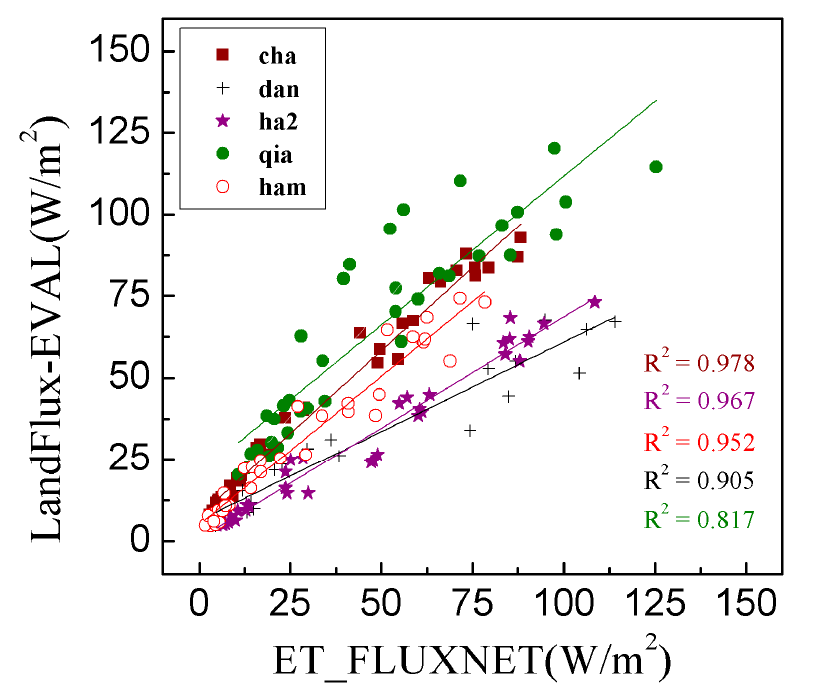
Figure 1. The scatter correlation of ET (evapotranspiration) monthly averages from FLUXNET with LandFlux-EVAL at 5 sites in China for 2003–2005. Sites are represented by different colors and shapes. The straight line is the linear fit for each site. R2 is the correlation coefficient.